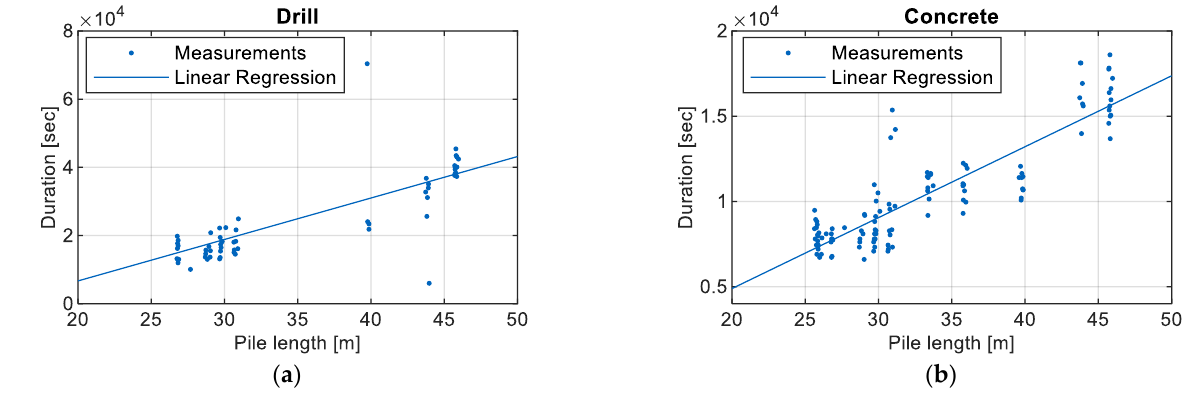
Figure 11. Linear regression for the processes: ( a ) drill; ( b ) concrete. Table 4. Parameters for the linear regression and residuals depending on the process.